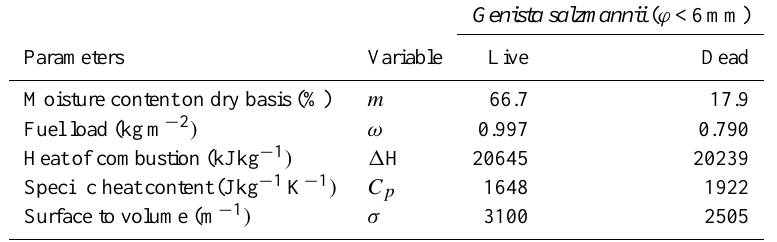
Table 1. Fuel characteristics derived from laboratory measurements for Genista salzmannii collected at the experimental site in Letia.